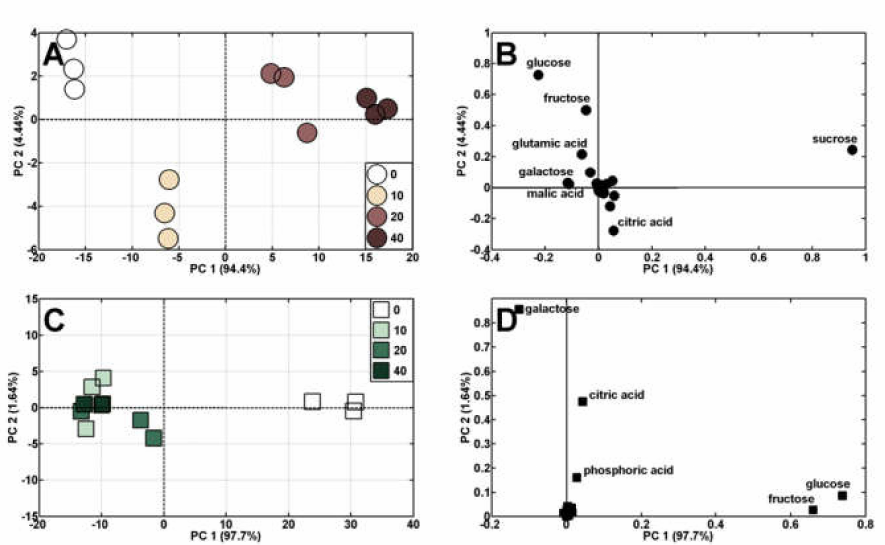
Figure 7. PCA profiles of roots ( A ) and coleoptile ( C ) metabolites of wheat seedlings developing in the presence of (Bio)Ag NPs at concentrations 0 (control), 10, 20, and 40 mg/L and PCA loading plots of the polar metabolites ( B , D